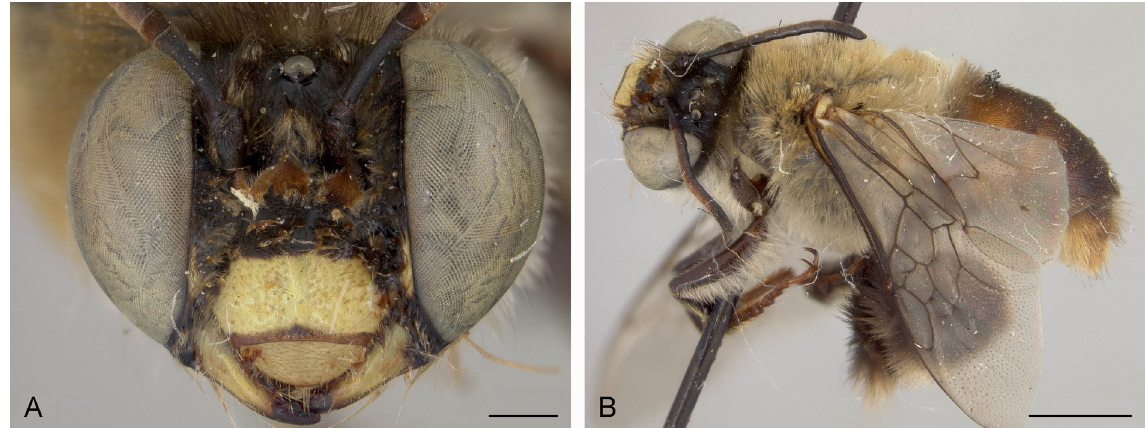
Fig. 14. Centris rufomaculata Cockerell, 1949, holotype, ♂ (NMNH; USNM ENT 00534213). A . Frontal view. B . Habitus, lateral view. Scale bars: A = 1 mm; B = 2